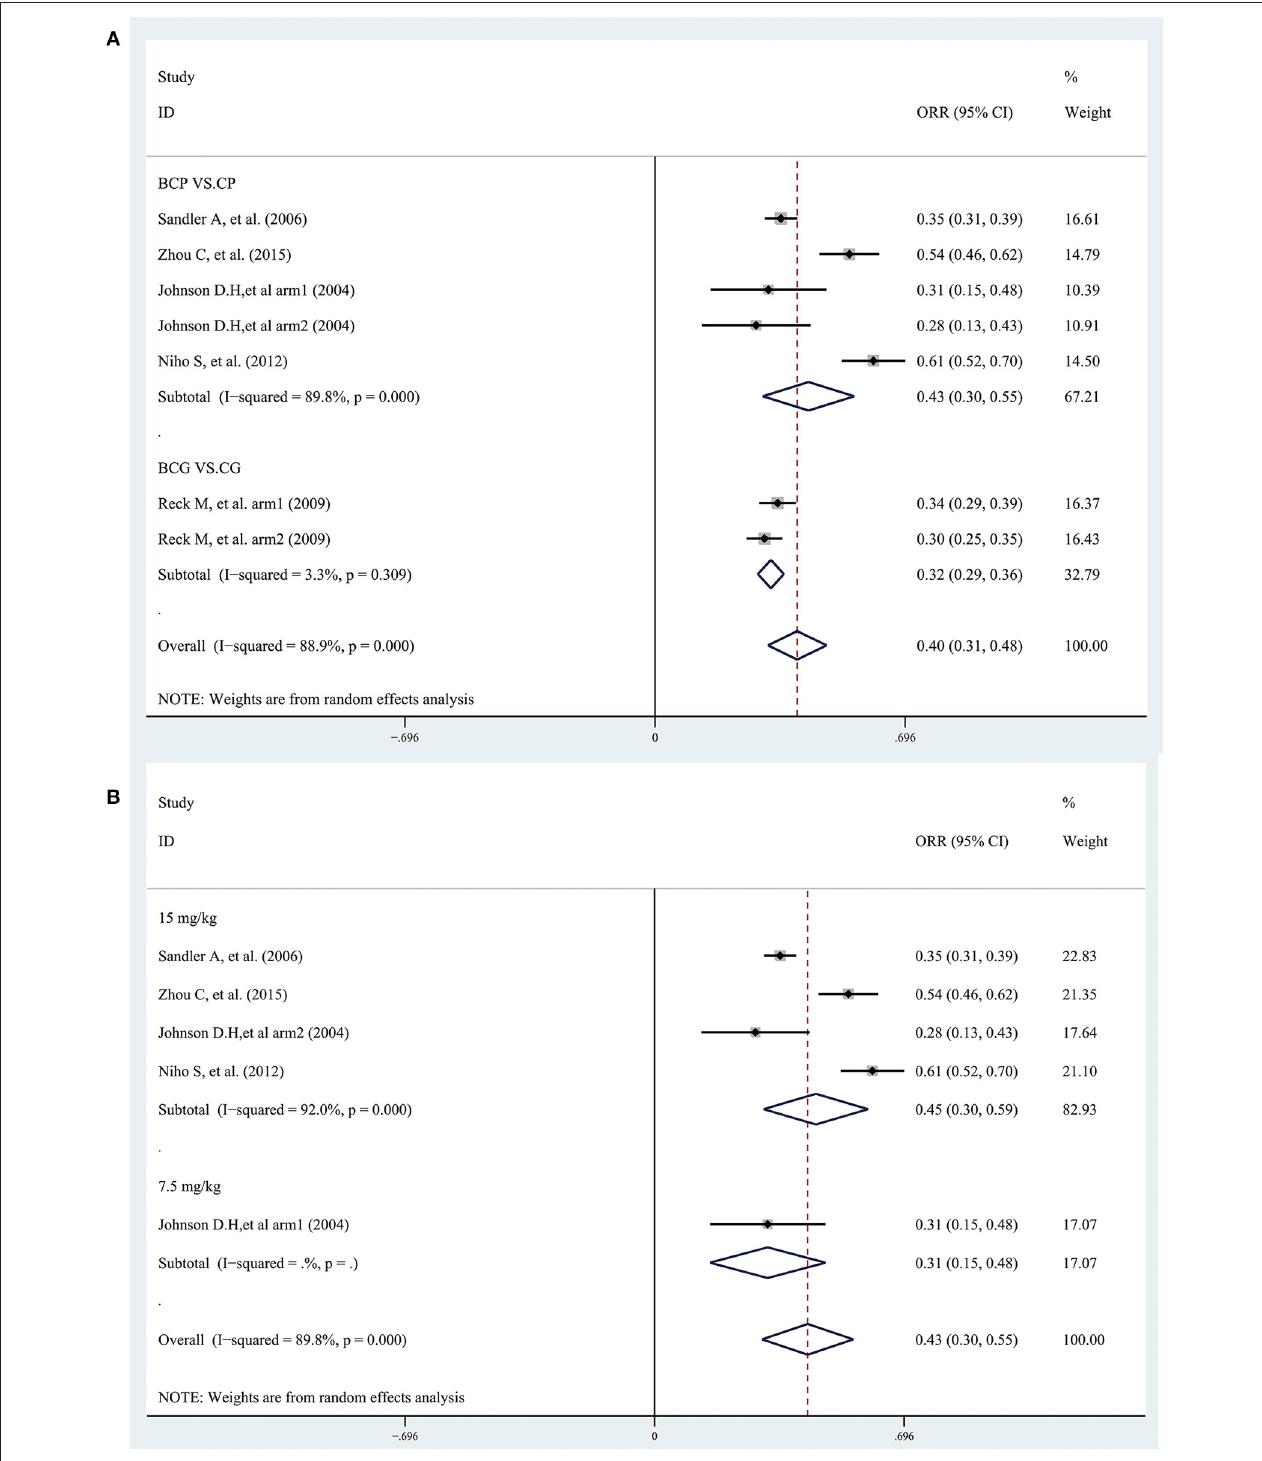
FIGURE 5 | Forest plots of the objective response rate (ORR) based on (A) treatment and (B) bevacizumab dose (7.5 mg/kg and 15 mg/kg) from randomized controlled trials of bevacizumab added to standard chemotherapy, compared with chemotherapy alone, as first-line therapy in patients with advanced NSCLC.